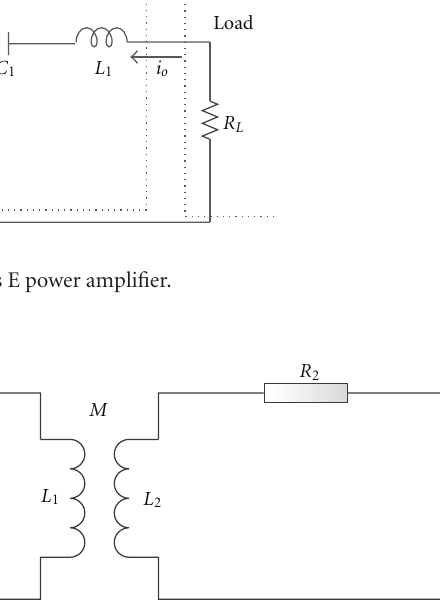
Figure 3: Schematic of inductively coupled